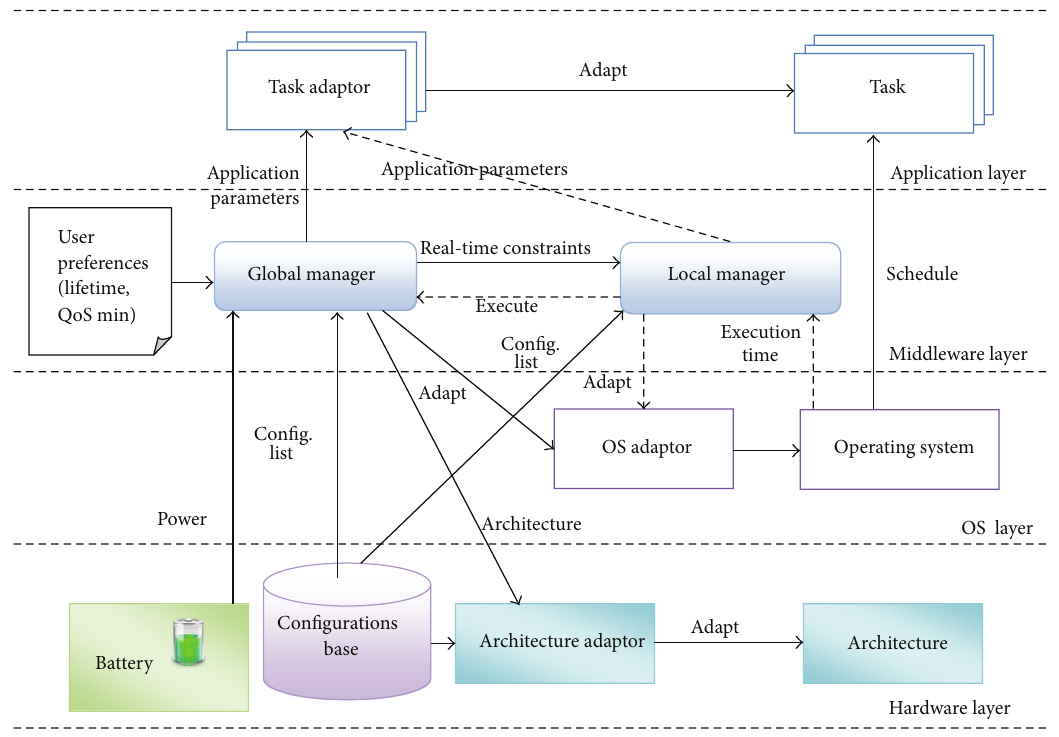
Figure 2: Cross-layer adaptation approach. Table 2: QoS results with 𝑓1 cost